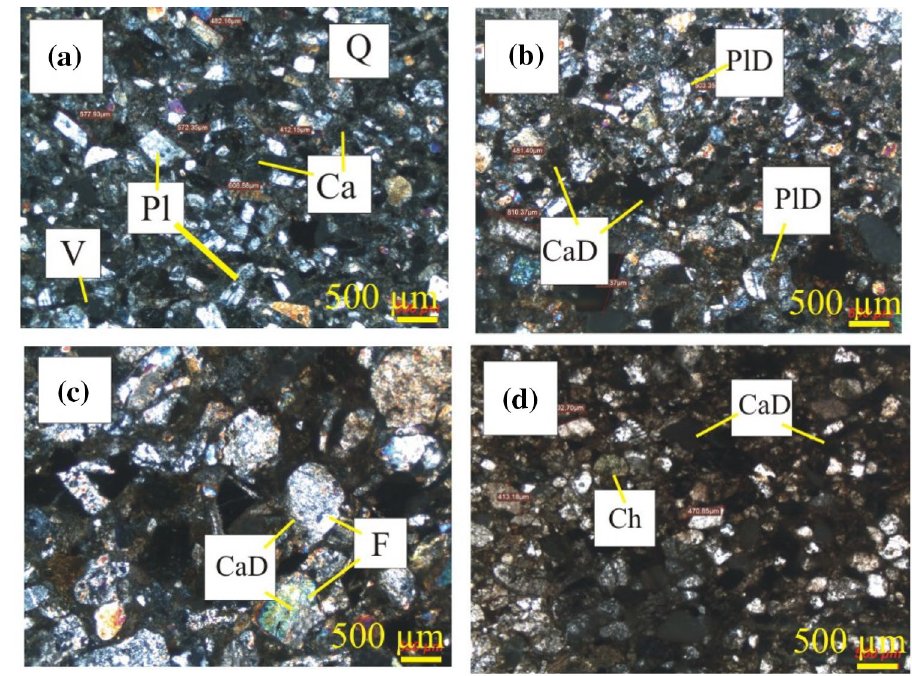
Fig. 6 Micrographs of the Haymana Formation sandstones (Litho- facies A sandstones) a Arkose is observed in the photo. Carbonate cement (Ca) (Early calcite) is seen. Carbonate cement occurs in scat- tered patches, occasionally completely filling pore as a early calcite cement. Q: Quartz, Pl: Plagioclase, V: Volcanic rock, L1 section, Sample number: 1A. b Dissolution of the Carbonate cement (CaD) and plagioclase (PlD) is common. L1 section, Sample number: 5A.